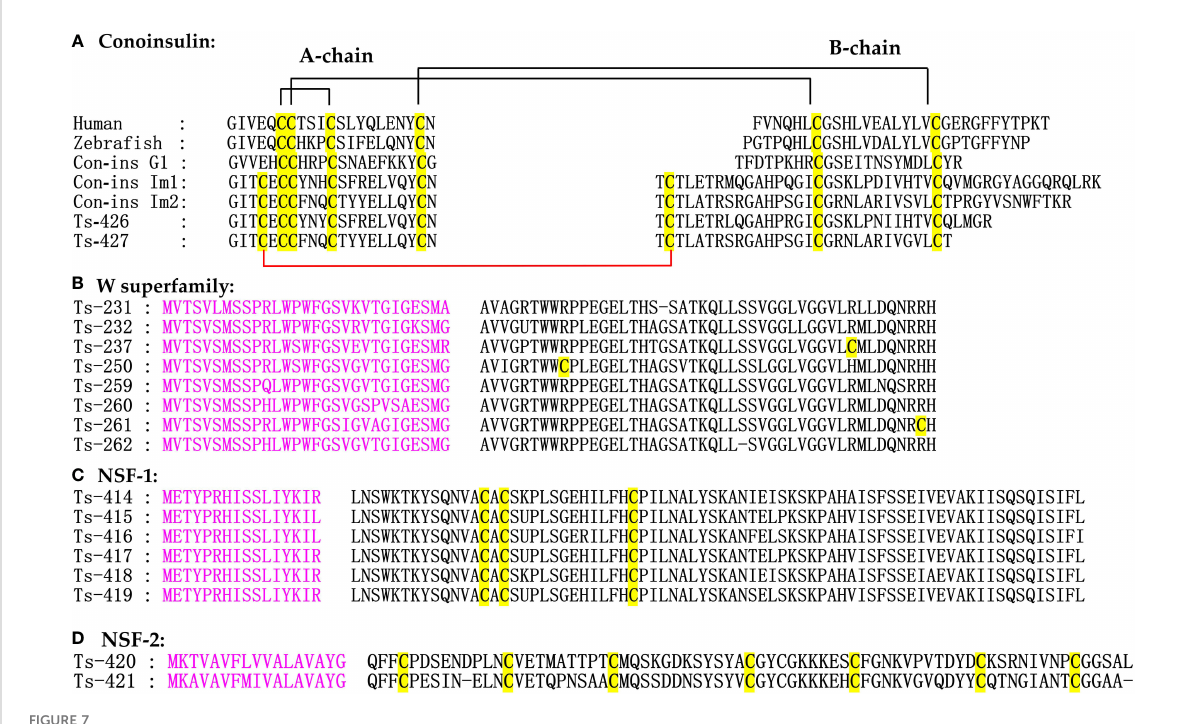
FIGURE 7 Alignment of the achieved Conoinsulines, W and New superfamilies sequences from our C. striatus transcriptomes. The signal regions (in pink) and cysteine residues (in yellow) are marked for